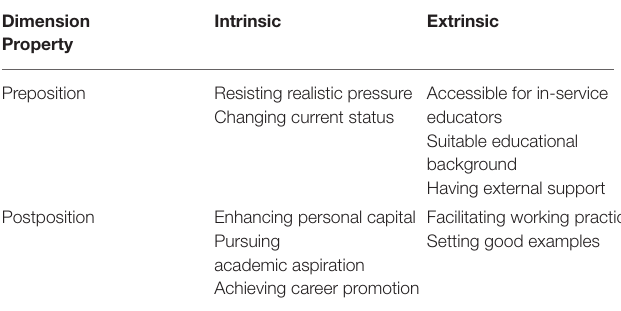
TABLE 4 | Types of motivations for pursuing an Ed.D. in